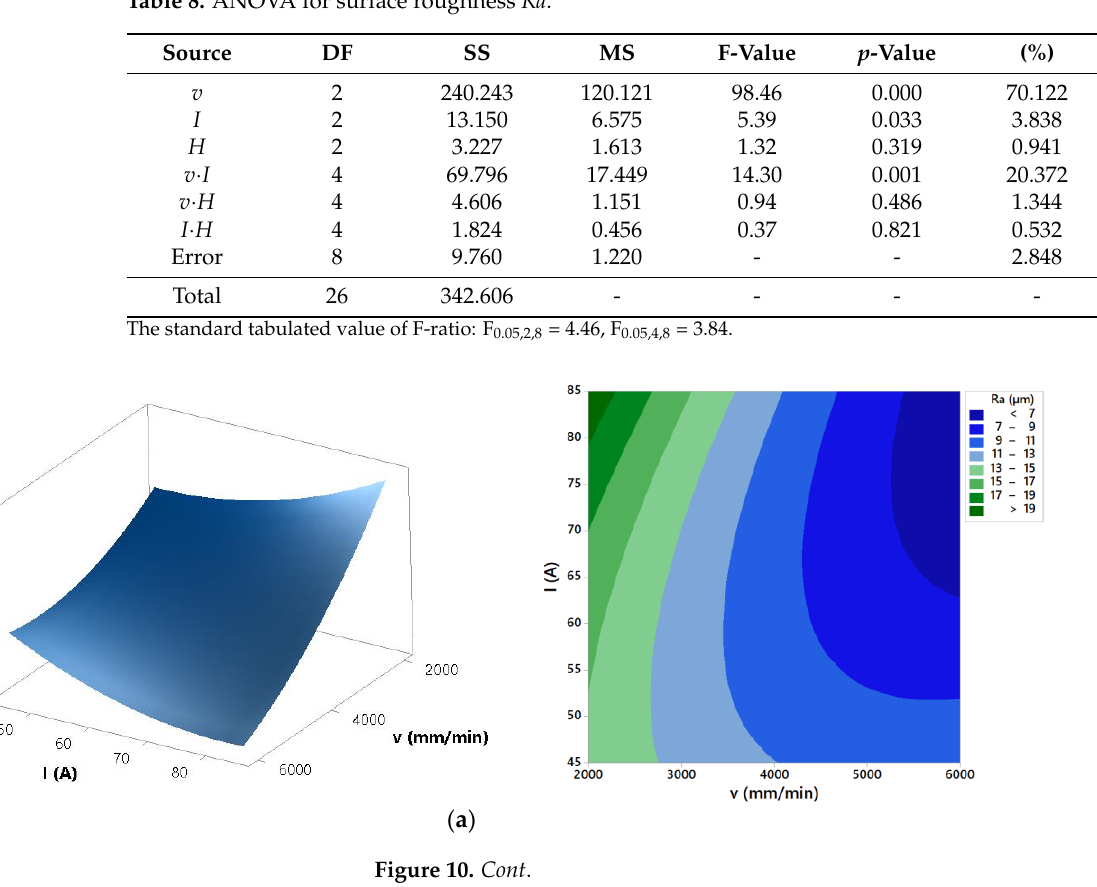
Figure 9. Experimental surface roughness Ra vs. predicted surface roughness Ra. Table 8. ANOVA for surface roughness Ra.